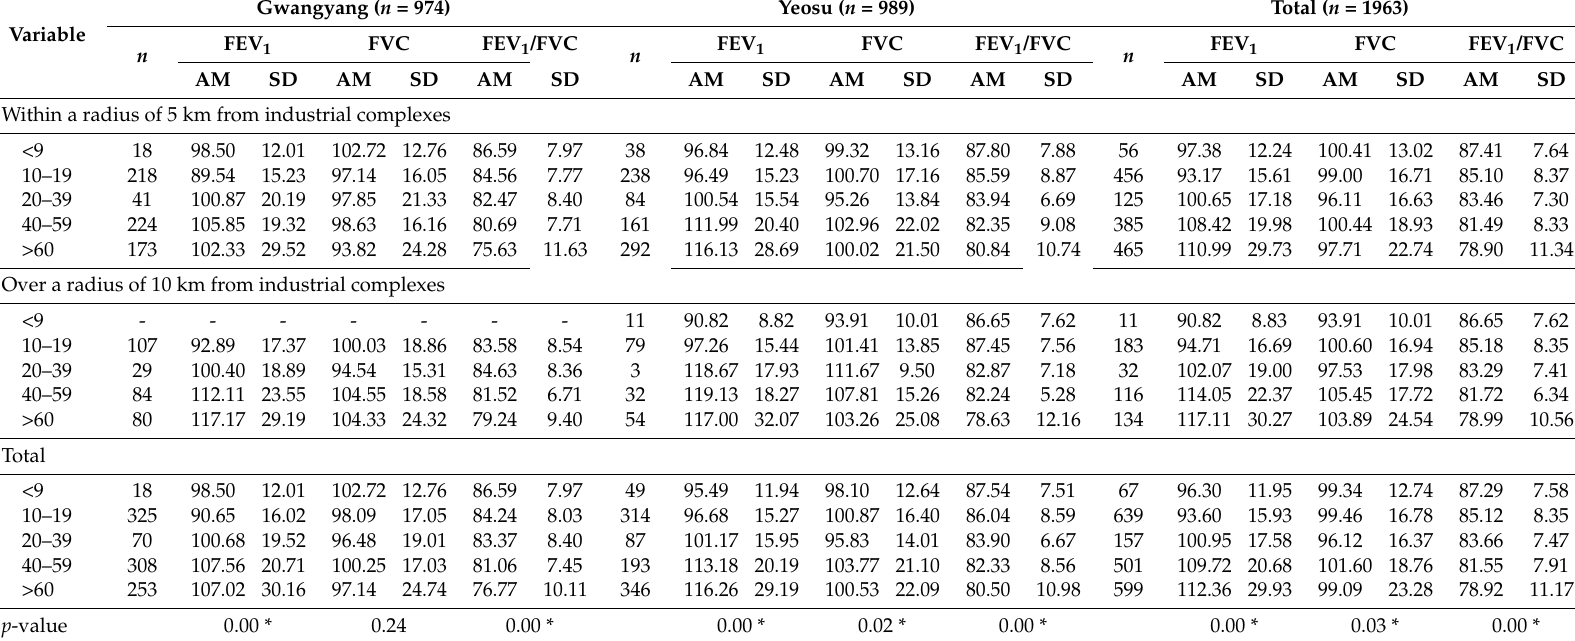
Table 4. Summary statistics of pulmonary function levels of distance from industrial complexes stratified by